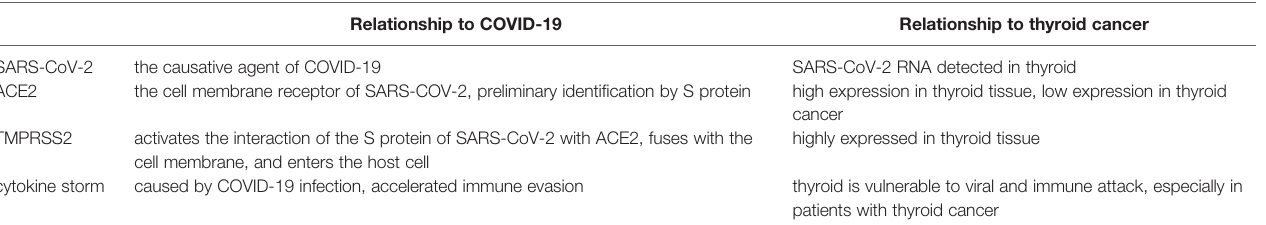
TABLE 1 | Correlation between COVID-19 and thyroid